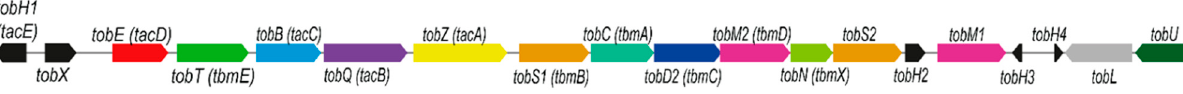
Figure 2. Tobramycin biosynthetic gene cluster (BGC) of Streptoalloteichus tenebrarius 2444 PS (https://www.dropbox.com/sh/jwxxdzh26worn7g/AADH7xfjNLeUB_V9MMBTYuuWa?dl=0). The National Center for Biotechnology Information